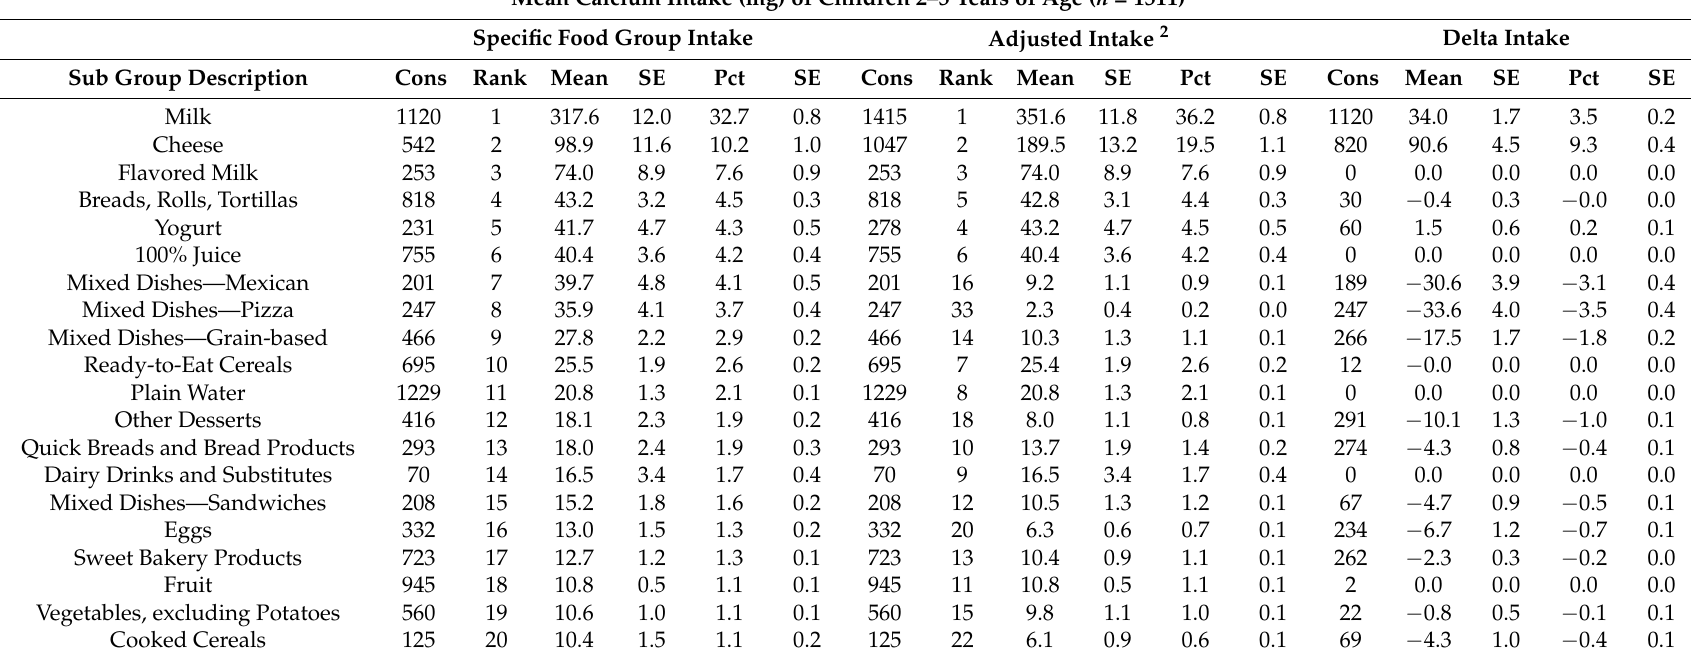
Table 3. Food/food group sources 1 of mean calcium (mg) intake among US children aged 2–18 years ( N = 5876): National Health and Nutrition Examination Survey